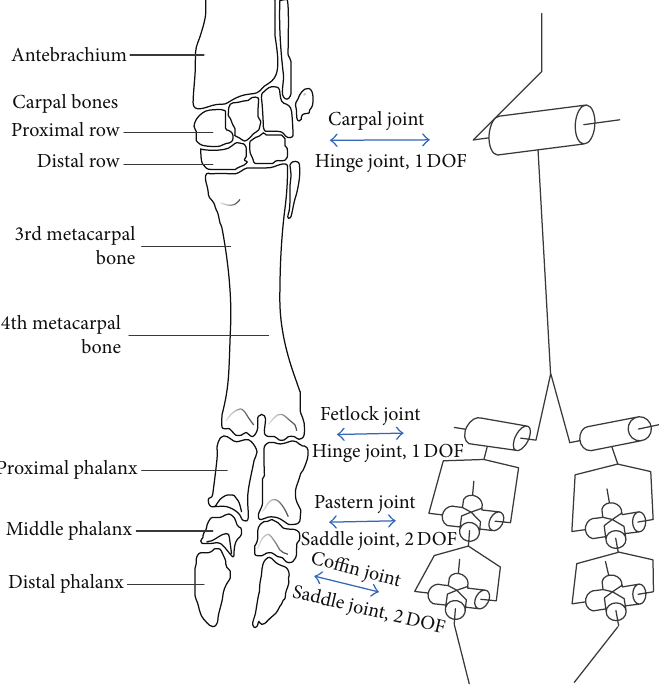
Figure 1: The skeleton and articulation of the ox’s manus (schematic), which can be equivalent to an articulated